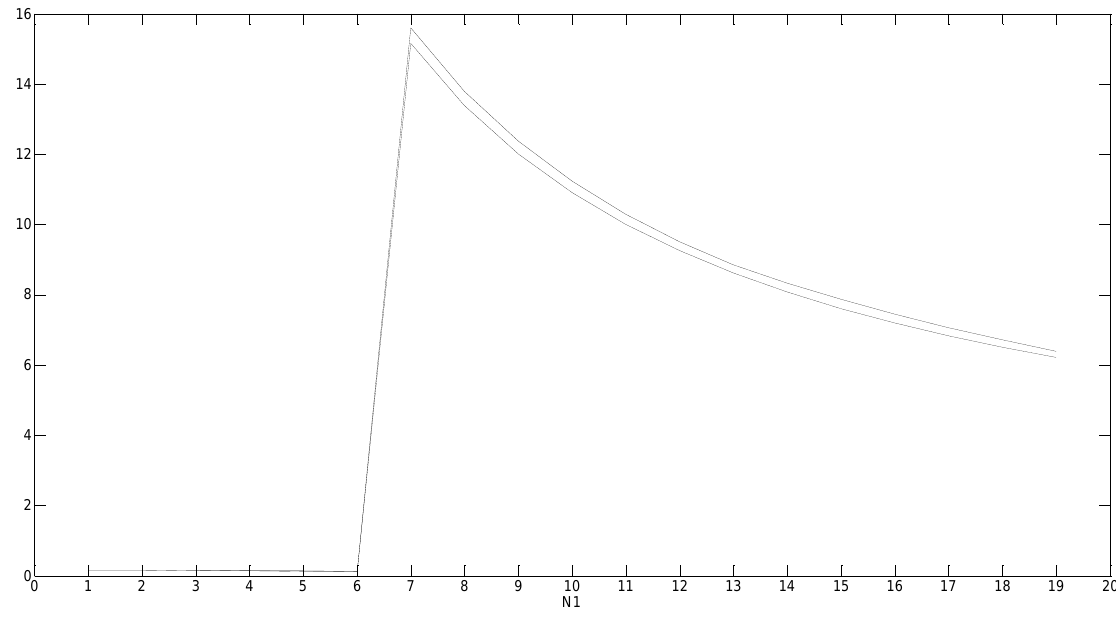
Fig. 11. Theoretical and numerical subsystems energy ratio, 1 2 E E , versus N 1 , in solid and dashed lines,